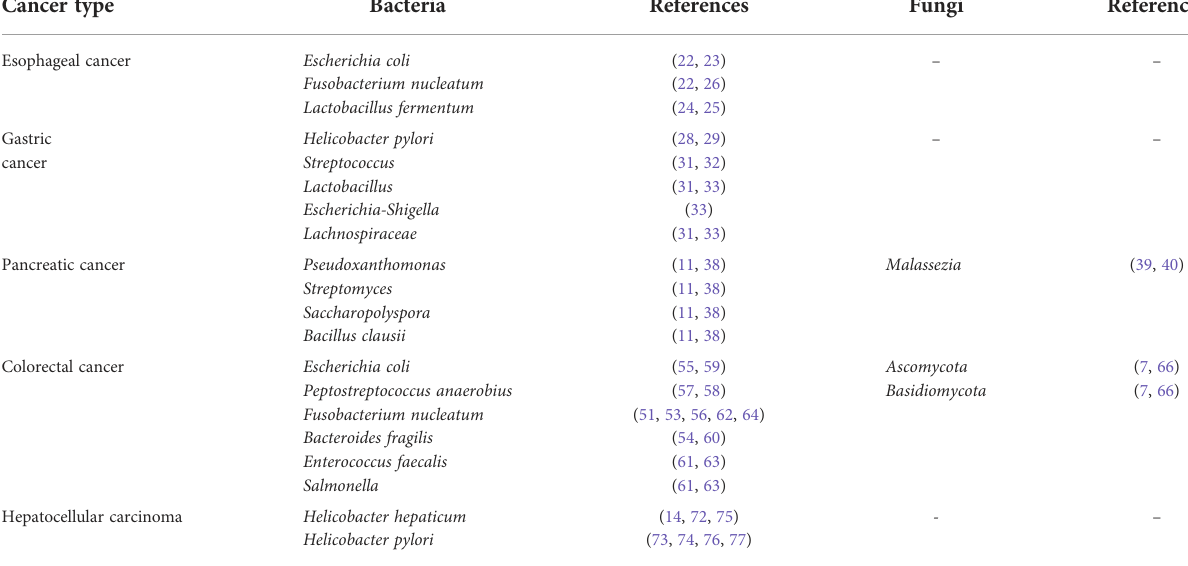
TABLE 1 Gastrointestinal cancer-associated intratumoral